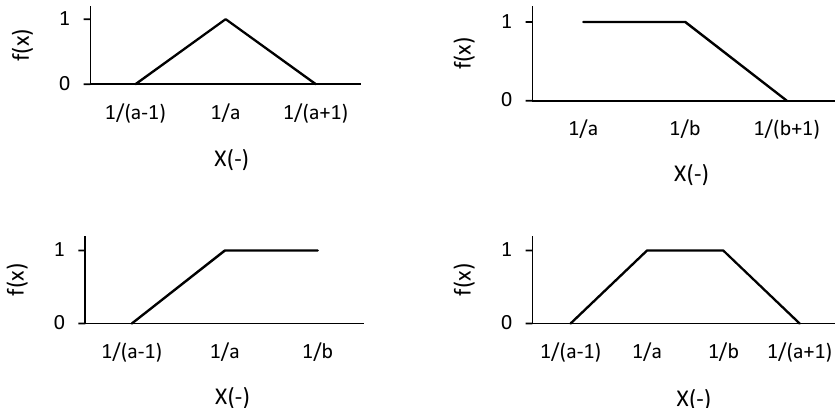
Fig. 3: Membership functions for trapezoidal fuzzy numbers of linguistic variables